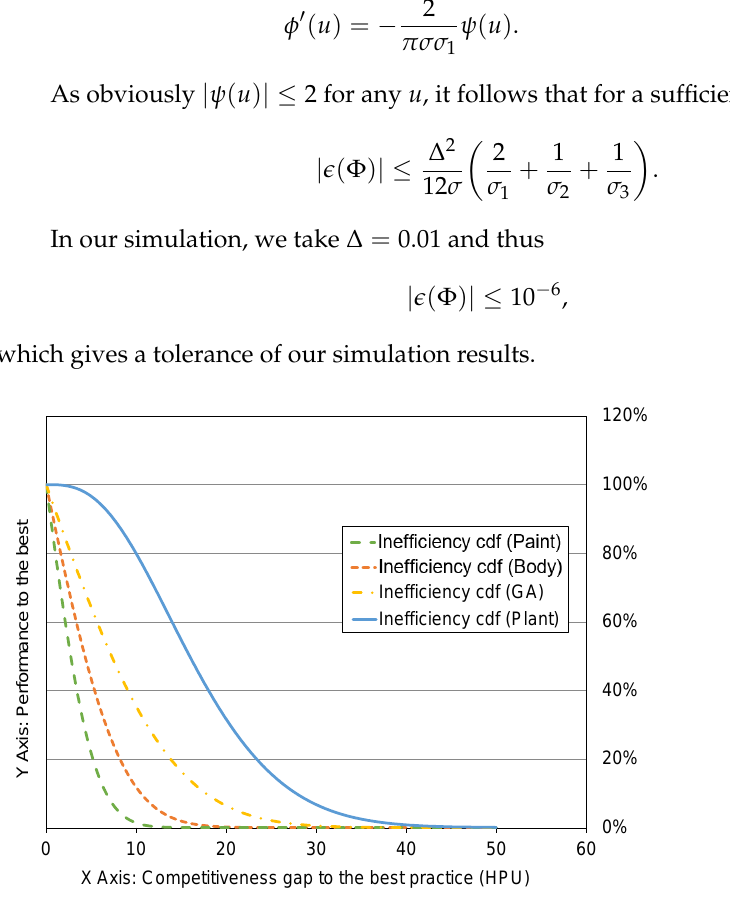
Figure 2. Cumulative distribution function of inefficiency for shops and overall